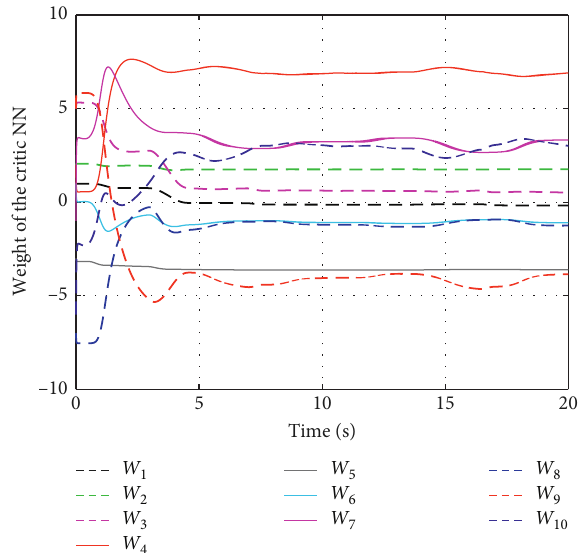
Figure 2: Convergence of the critic NN weights.